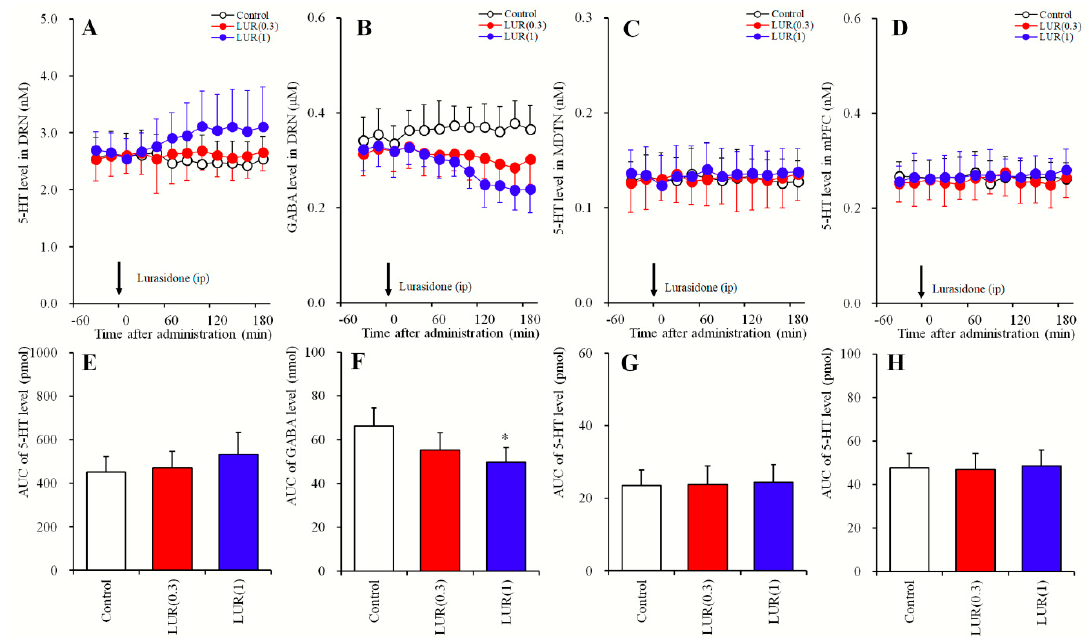
Figure 1. Dose-dependent e ff ects of systemic administration of lurasidone on extracellular levels of 5-HT in the DRN, MDTN, mPFC and γ -aminobutyric acid (GABA) in the DRN (Study_1). ( A , C , D ) indicate dose-dependent e ff ects of intraperitoneal administration of lurasidone (LUR: 0, 0.3 and 1 mg / kg) on extracellular levels of 5-HT in the DRN, MDTN and mPFC, respectively. ( B ) indicates dose-dependent e ff ects of intraperitoneal administration of lurasidone (LUR: 0, 0.3 and 1 mg / kg) on extracellular GABA level in the DRN. Y -axis: Mean ± SD (n = 6) of extracellular levels of 5-HT (nM) and GABA ( µ M); X -axis: Time after administration of lurasidone (min). Arrows indicate intraperitoneal administration of lurasidone. Microdialysis was conducted to measure the releases of 5-HT and GABA. ( E – H ) indicate the area under curve (AUC) value of extracellular levels of 5-HT (pmol) and GABA (nmol) after intraperitoneal administration of lurasidone from 20 to 180 min of ( A – D ), respectively. Opened, red and blue columns represent the AUC values of 0, 0.3 and 1 mg / kg lurasidone administration, respectively. * P < 0.05; relative to control (lurasidone free) by MANOVA with Tukey’s post hoc test.